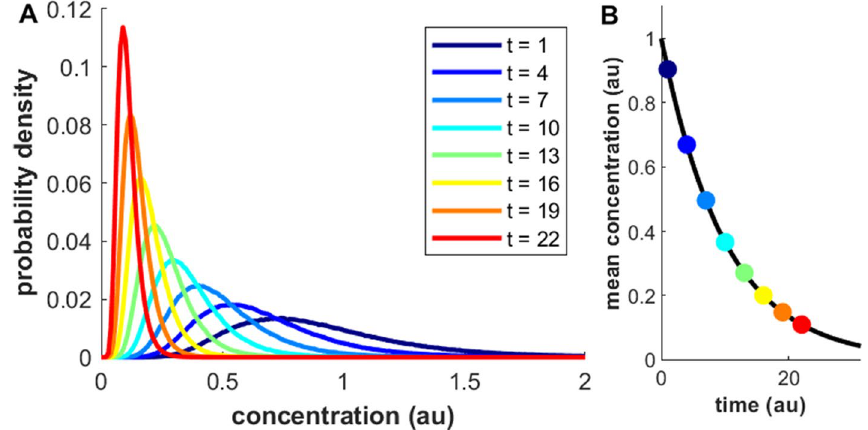
Figure 1. Illustration of the temporal evolution of a log-normal concentration distribution during continuous kinetic degradation. Panel ( A ): Concentration distributions depicted at different times (t = time; Eqs. 3 and 4a–b). Panel ( B ): Temporal evolution of the corresponding mean concentrations, displaying exponential decay (Eq.